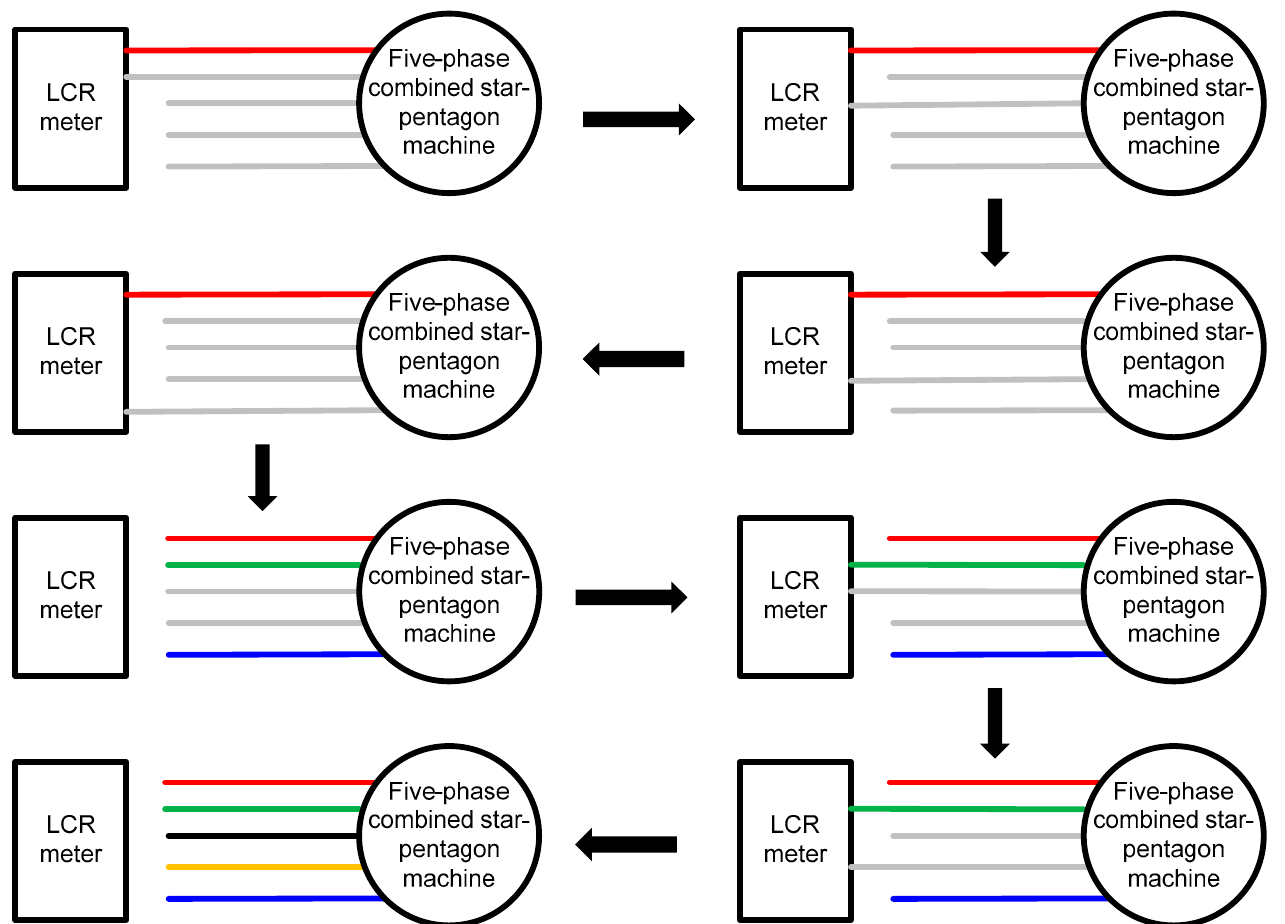
Figure 9. Steps of phases sequence identification represented in star of slot phasors, ( a ) phasors of phases before applying the first test, ( b ) the result of the first step and ( c ) the final result of the two setps. The question mark (?) means that the sequence order of this terminal is not identified yet.